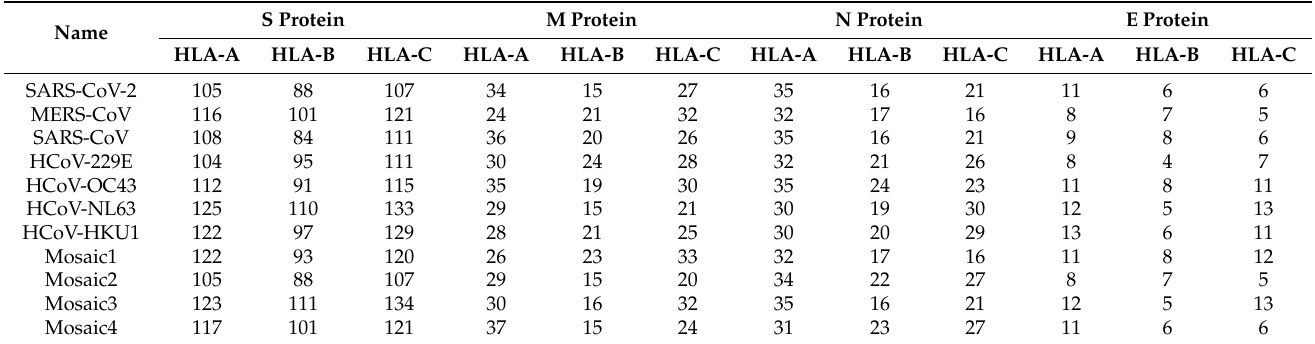
Table 3. The number of potential cytotoxic T lymphocyte (CTL) epitopes in HCoVs structure proteins.